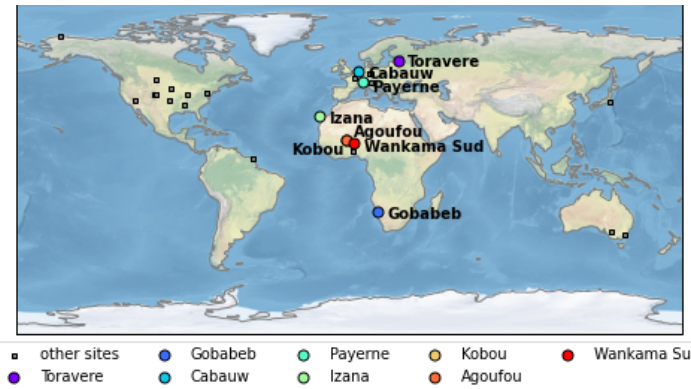
Figure 1. Ground stations used for the local-scale analysis. Colored circles correspond to stations where long time-series (about four-year periods) are assessed.